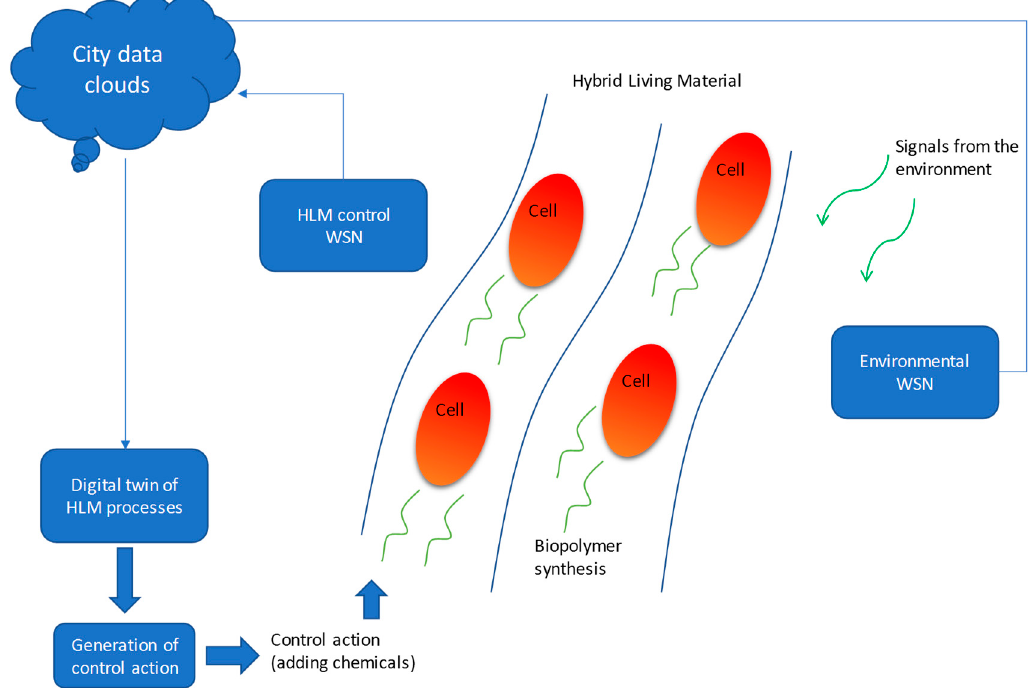
Figure 5. Cyber-physical system (CPS) with hybrid living material (HLM) and two wireless sensor networks (WSNs) for process control.